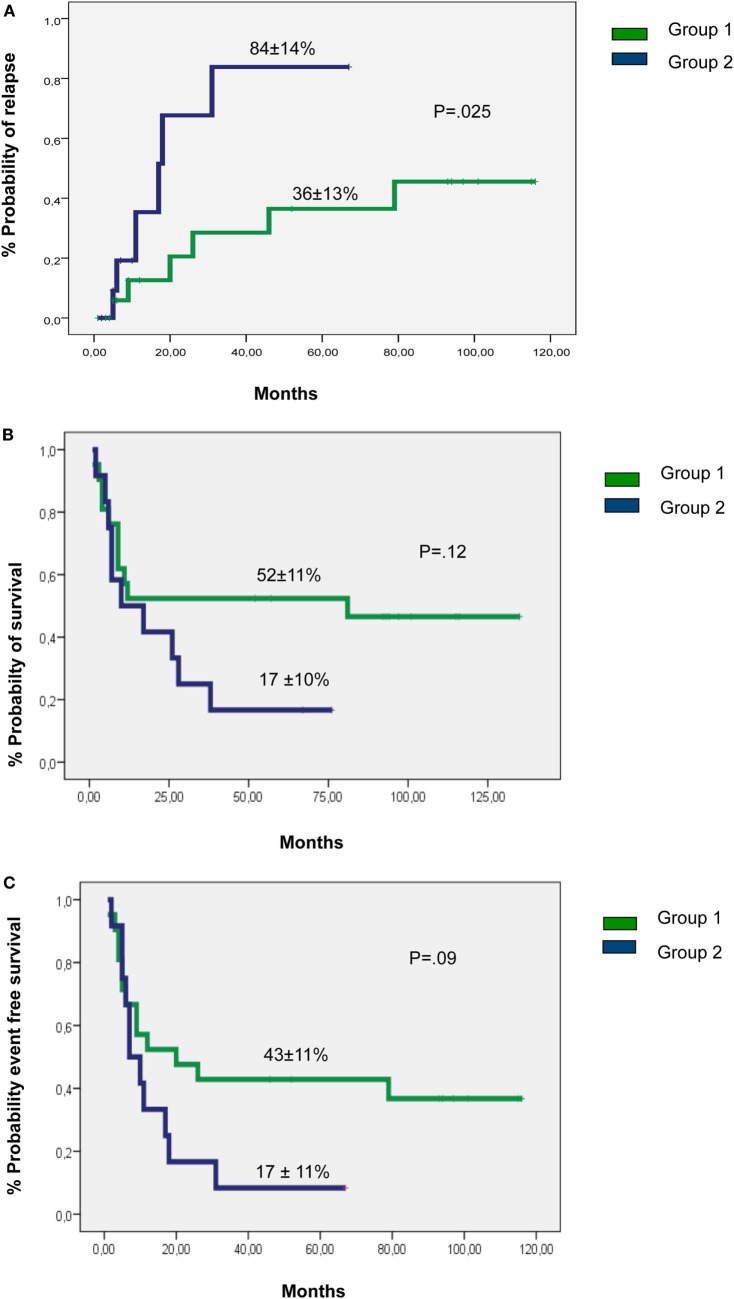
Probability of (A) relapse, (B) overall survival, and (C) event-free survival by groups 1 or 2.